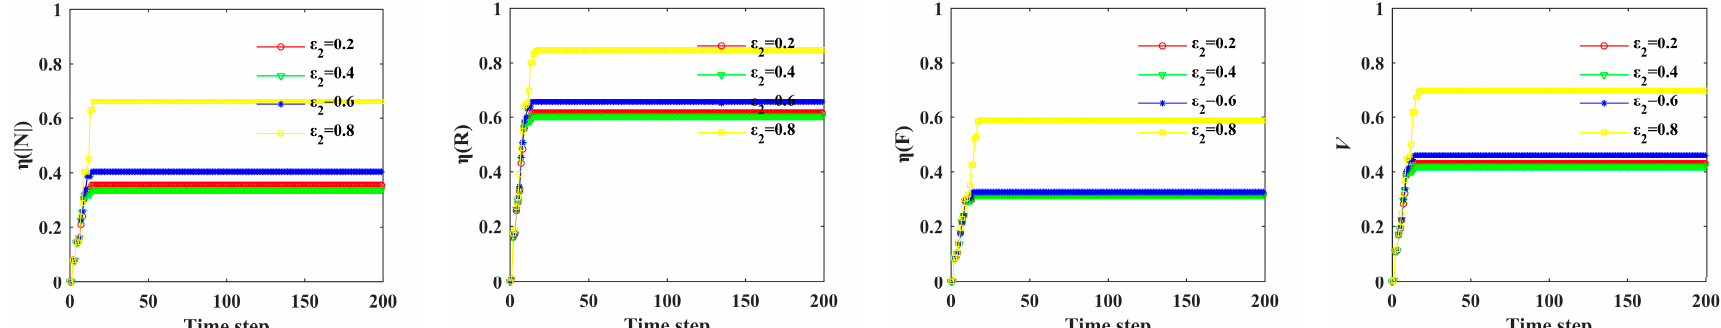
Figure 11. Cascading failures of Bus–Metro CBN under different edge coupling strengths. ( a – c ) show the loss ratio of node scale in the maximum connected subgraph, the network efficiency and the passenger flow with time under different edge coupling strengths, respectively. ( d ) shows the change of network vulnerability with time under different edge coupling strengths. Note: in these scenarios, s = 1.0, α = 0.3, ε 1 = 0.2, λ 1 = λ 2 = λ 3 = 1